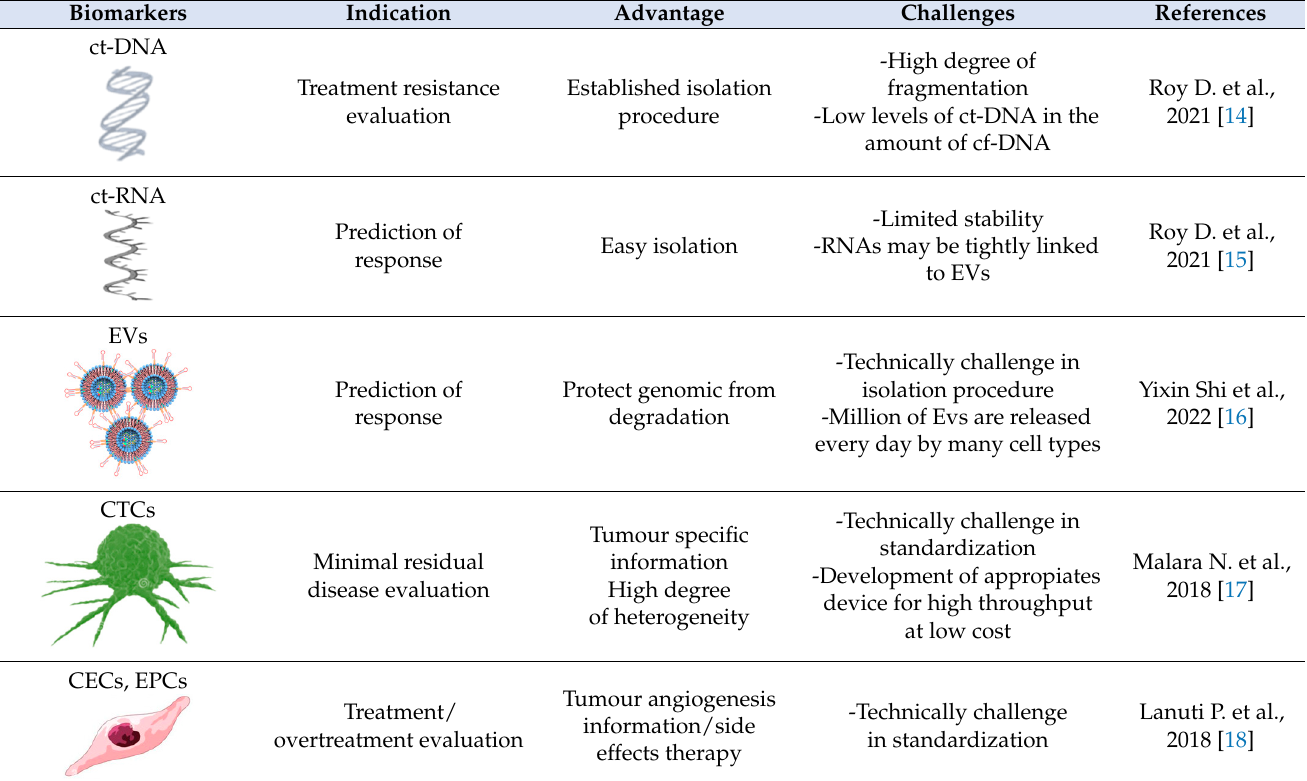
Table 1. Table 1. Circulome. Table 1. Circulome.